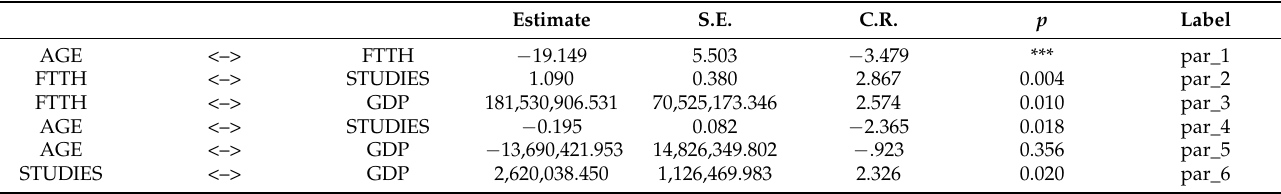
Table A15. Covariances: (Group number 1-Default